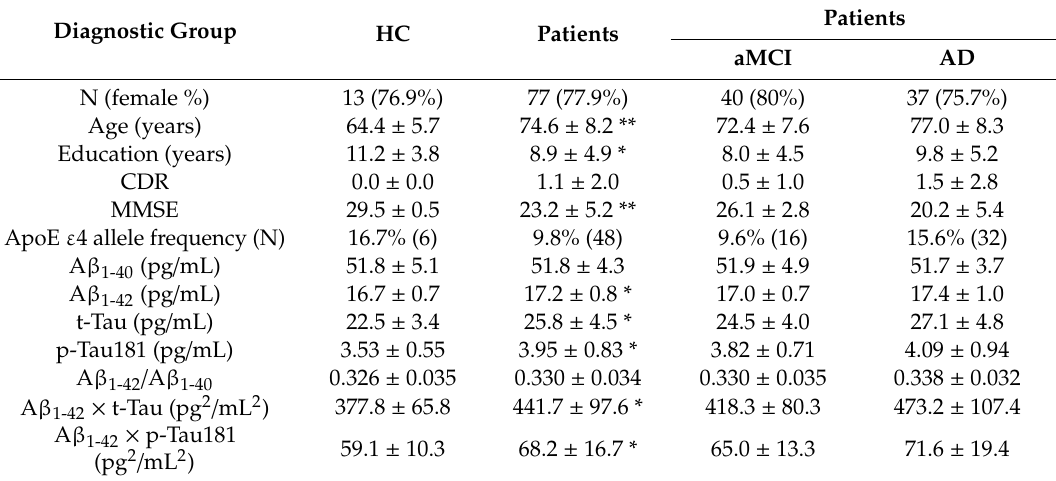
Table 1. Baseline demographic information of enrolled